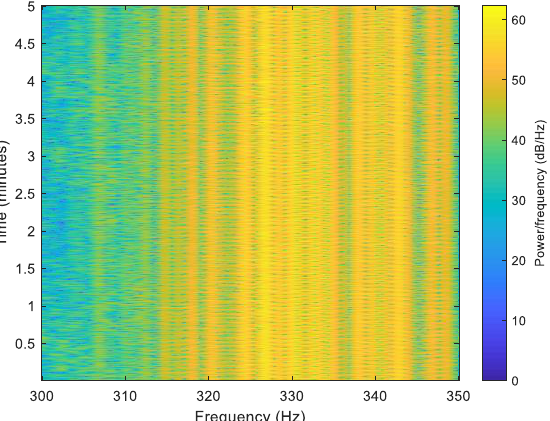
Figure 6. The spectrogram of the experimental data of hydrophone No. 24.